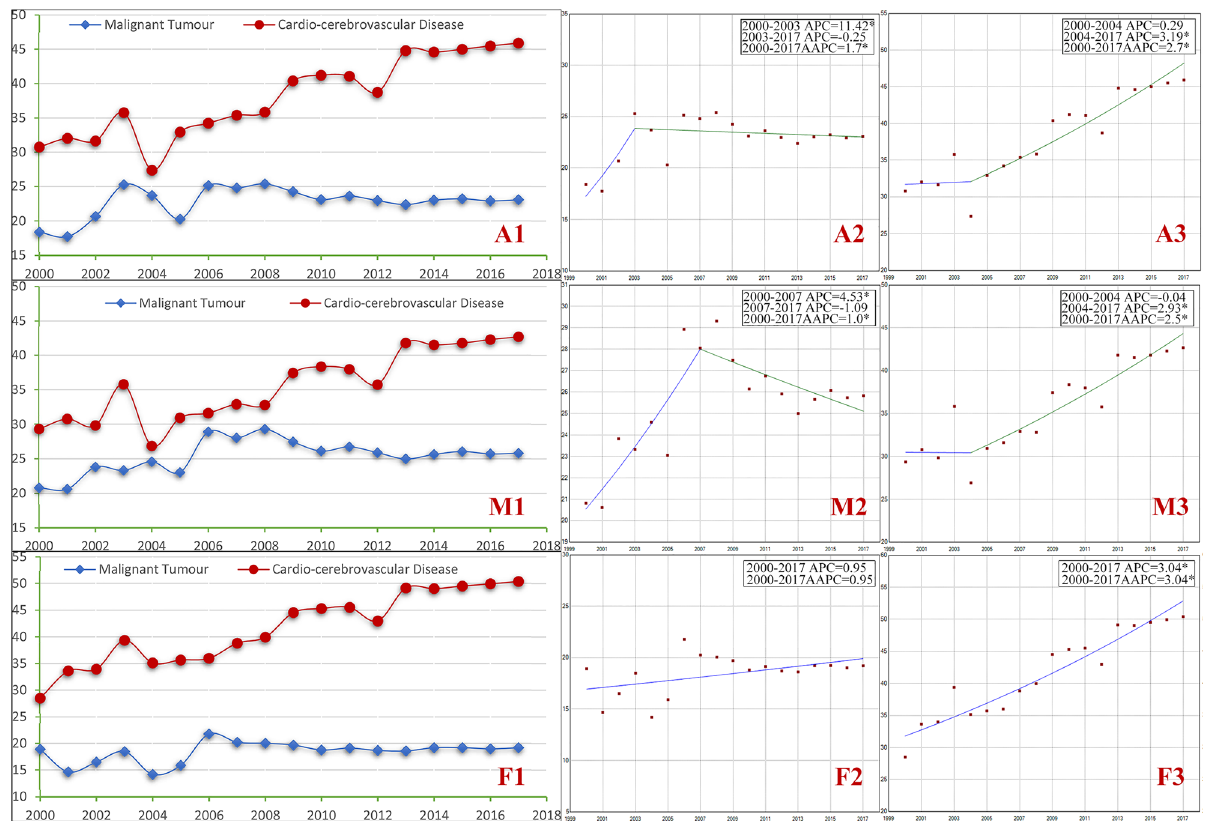
Figure 2. Comparison of trends for malignant tumor and cardio-cerebrovascular disease as causes of death in rural areas of China from 2000 to 2017. Note A all; M male; F female; 1 line chart based on raw data; 2 Joinpoints graph for malignant tumor; 3 Joinpoints graph for cardio-cerebrovascular disease; APC Annual Percent Change; AAPC Average Annual Percent Change; *Indicates that AAPC or APC is significantly different from zero at the alpha = 0.05 level. x-axis: year; y-axis: the proportion of